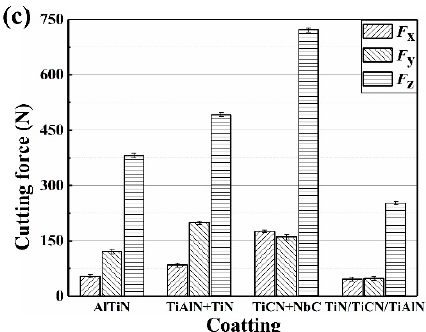
Figure 5. Effect of coatings on cutting force at ( a ) v c = 280 m/min, ( b ) v c = 360 m/min, and ( c ) v c = 440 m/min, f z = 0.04 mm/z, a p = 0.4 mm, and a e = 4 mm.